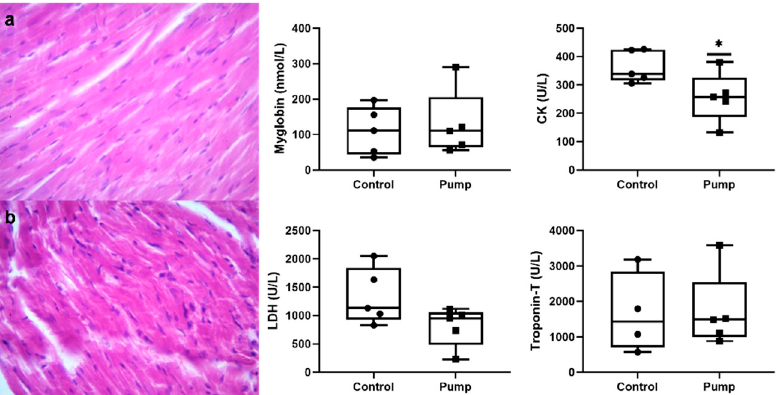
Figure 2. Morphological and functional evaluation of cardiac and hind muscle of irisin-treated rats. Cardiac tissue sections of ( a ) control and ( b ) irisin (pump)-treated animals ( × 40). Levels of muscle activity parameters including myoglobin; CK: creatine kinase; LDH: lactate dehydrogenase, and troponin-T were analyzed in the serum of control and irisin-treated animals. * p -value < 0.05.